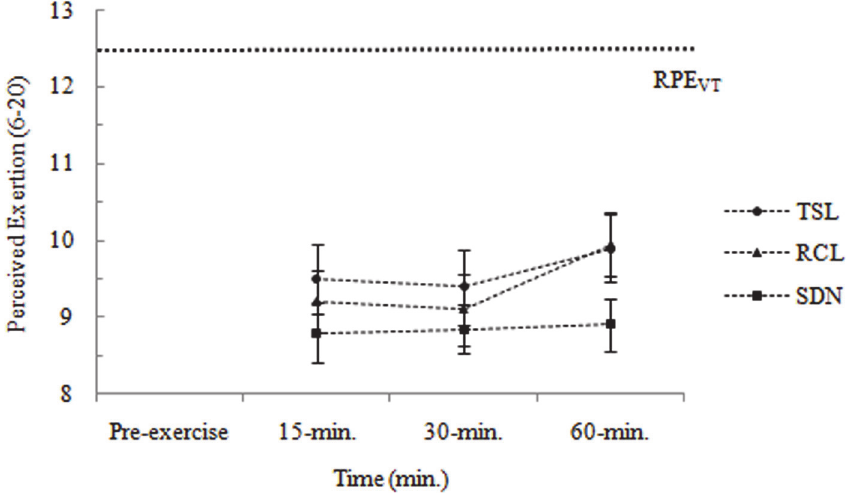
Fig 2. Exertional responses (6 – 20) during the three Salsa dance conditions. Data are shown as means ± SE. TSL: Typical Salsa lesson; RCL: Rueda de Casino lesson; SDN: Salsa dance at a night club; RPE VT : rating of perceived exertion at-VT; VT: ventilatory